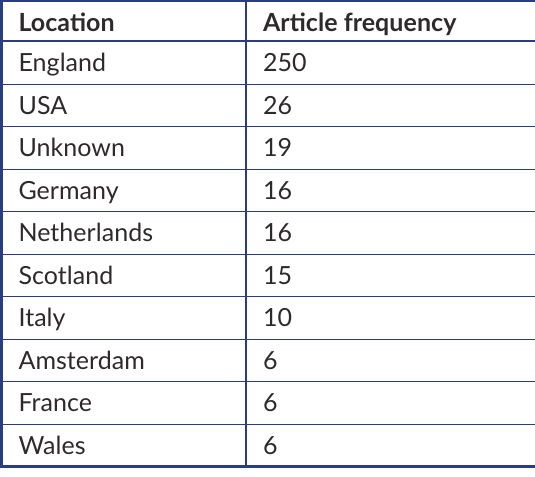
Table 6: Ten most frequent countries represented by author institutions in TRAC